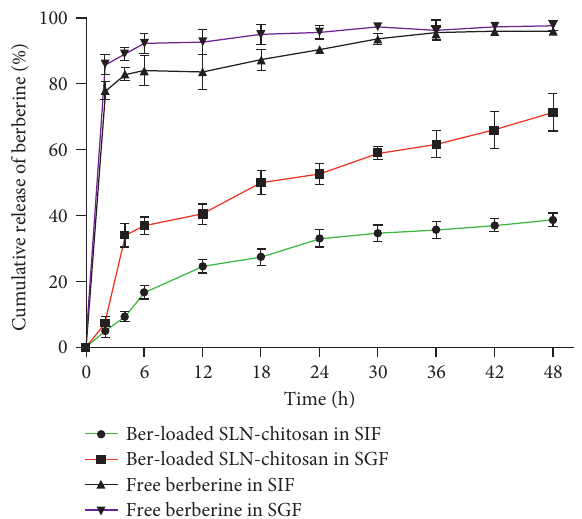
Figure 2: In vitro cumulative release profiles of free berberine and Ber-loaded SLN-chitosan nanoparticles in simulated gastric fluid (SGF, pH 1.5) and simulated intestinal fluid (SIF, pH 6.8).